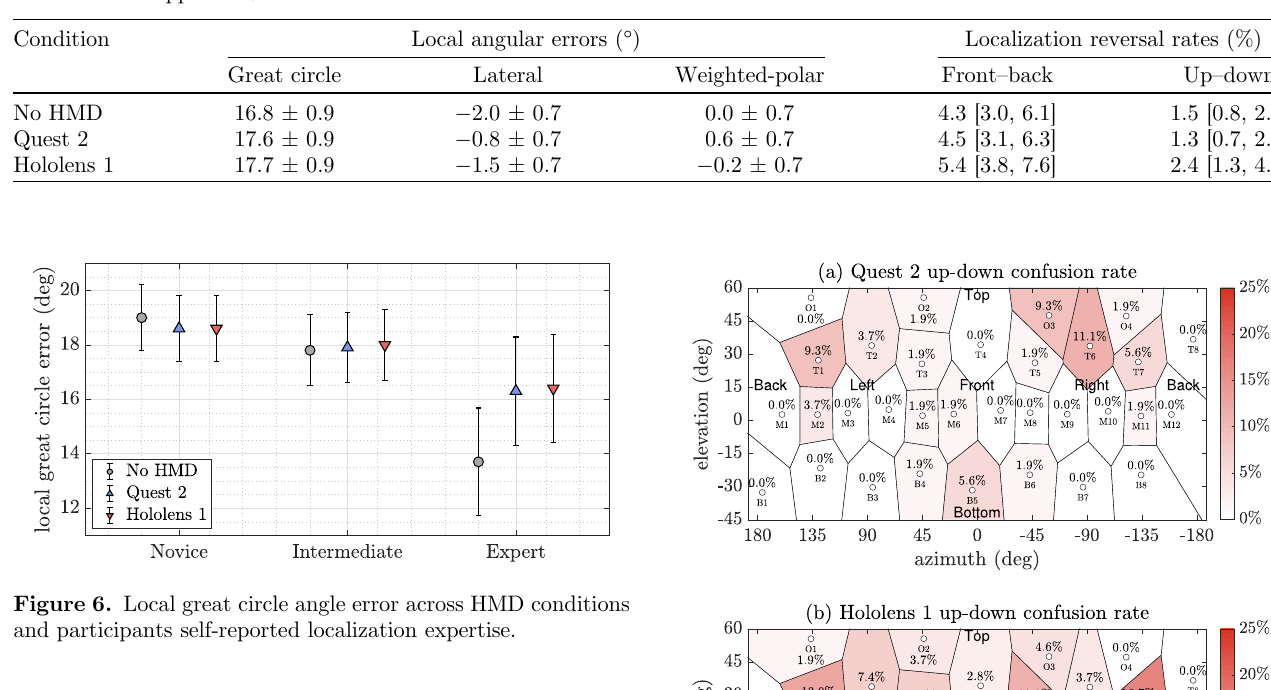
Table 1. Summary of localization performance for the three HMD conditions detailing the Tukey-adjusted local angular metrics and localization reversal rates. Reported ± values for angular metrics are standard errors. Reported ± values for localization reversal rates are lower and upper 95% con fi dence intervals.